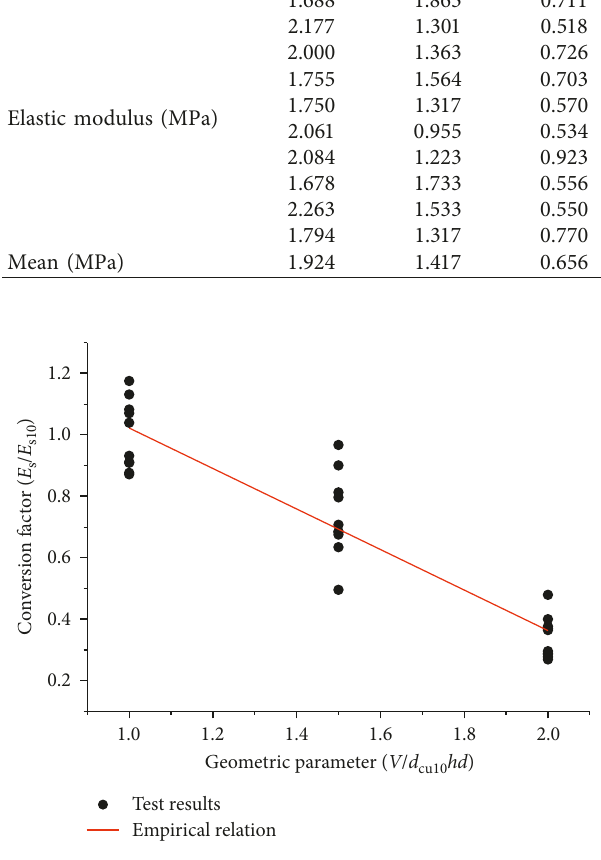
Figure 10: Empirical relation of conversion factors for elastic